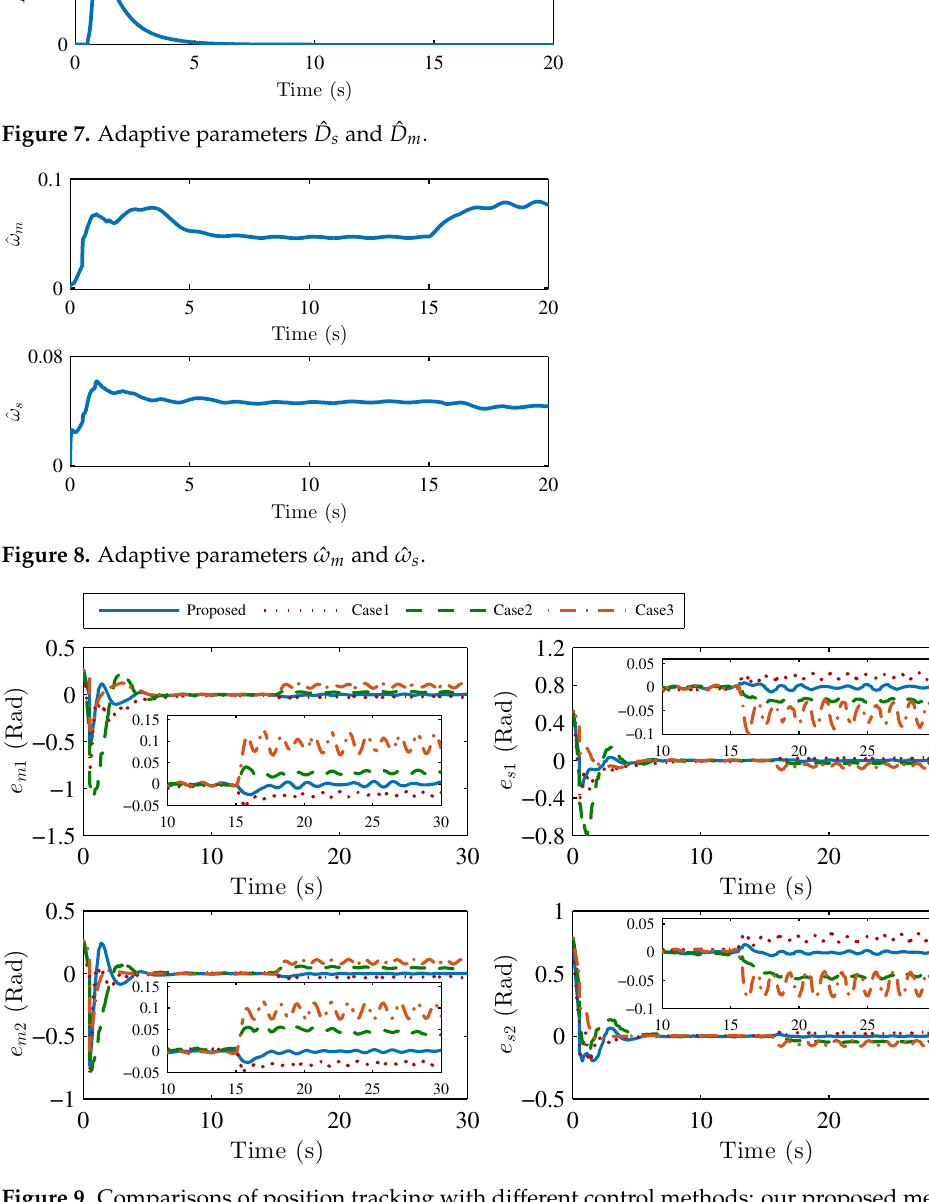
Figure 9. Comparisons of position tracking with different control methods: our proposed method, simulation case 1, simulation case 2, and simulation case